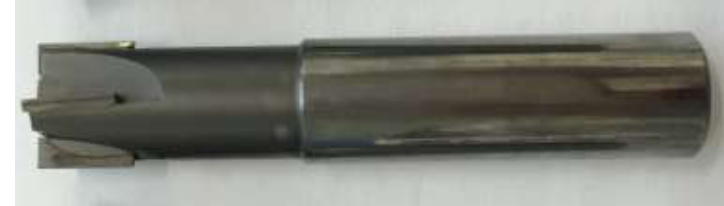
Figure 6. The staggered PCD end mill.